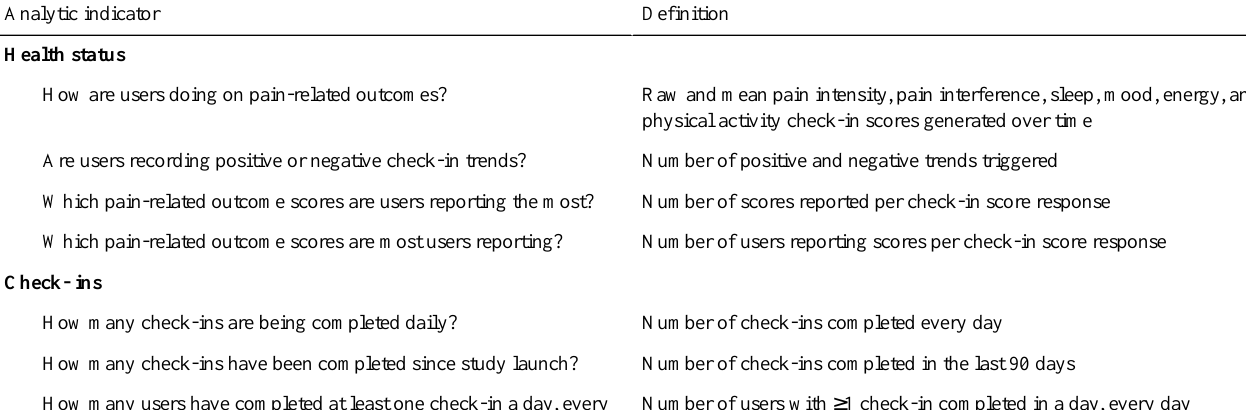
Table 1. Analytic indicators of effective engagement with iCanCope . DefinitionAnalytic